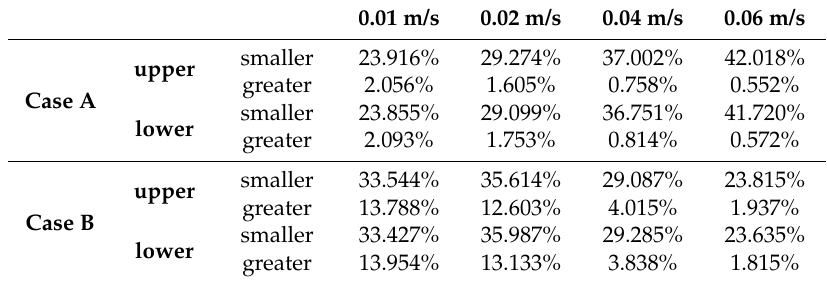
Table 1. The ratio of the control area to total area for the values of shear stress, which are smaller than 10% maximum value or greater than 90% maximum